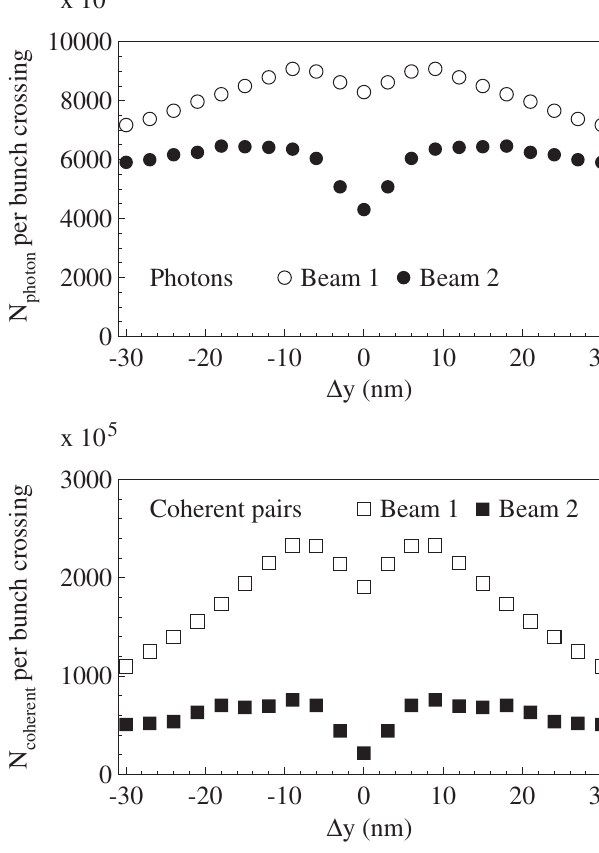
FIG. 27. Variation of the amount of beamstrahlung photons (top) and coherent pairs (bottom) when scanning one beam through the other at the interaction point, assuming that the incoming beam (1) has twice larger transverse dimensions than the incoming beam